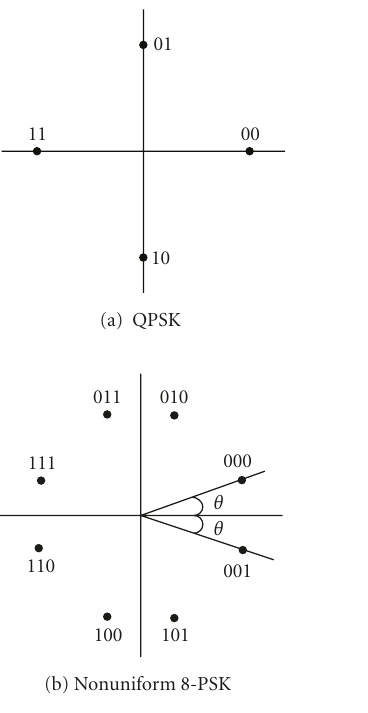
Figure 2: Adaptive nonuniform 8-PSK signaling constellation.